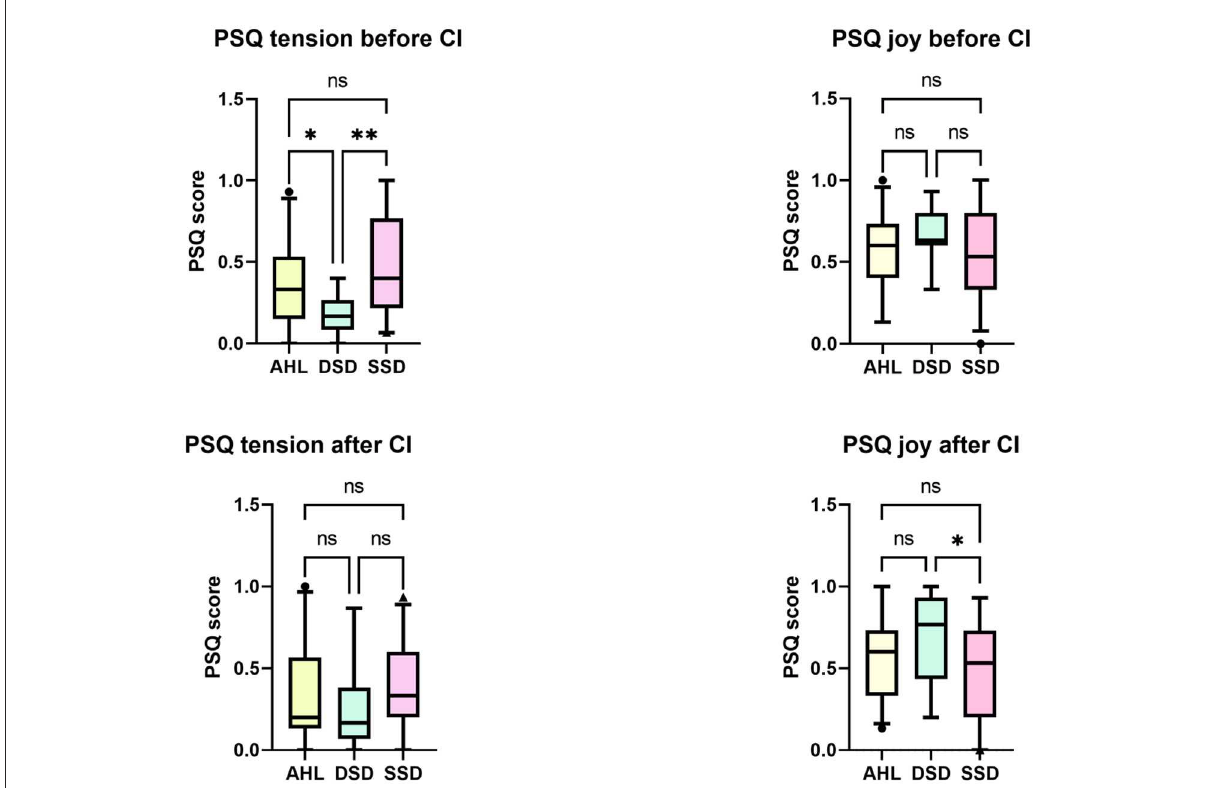
FIGURE5 Between-groups differences in the perceived stress (PSQ). At the study onset, the DSD group reported significantly less tension than the AHL and SSD patients. Six months after implantation, there were no longer differences detected with the Kruskal-Wallis test. * p < 0.05. ** p < 0.01 after Bonferroni correction. ns, not